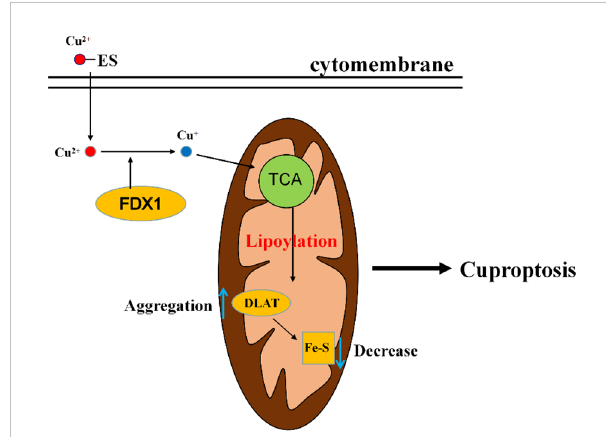
FIGURE 3 A diagram of the simple mechanism of cuproptosis. Elesclomol imports Cu 2+ into the cell, and then reduced to Cu + by FDX1. Cu + binds to lipoylated components of the mitochondrial TCA cycle, promoting lipoylated protein aggregation followed by a decrease in iron-sulfur cluster proteins, thereby inducing proteotoxic stress, leading to cell death. ES, elesclomol; FDX1, ferredoxin 1; DLAT, dihydrolipoyl transacetylase; TCA, tricarboxylic acid